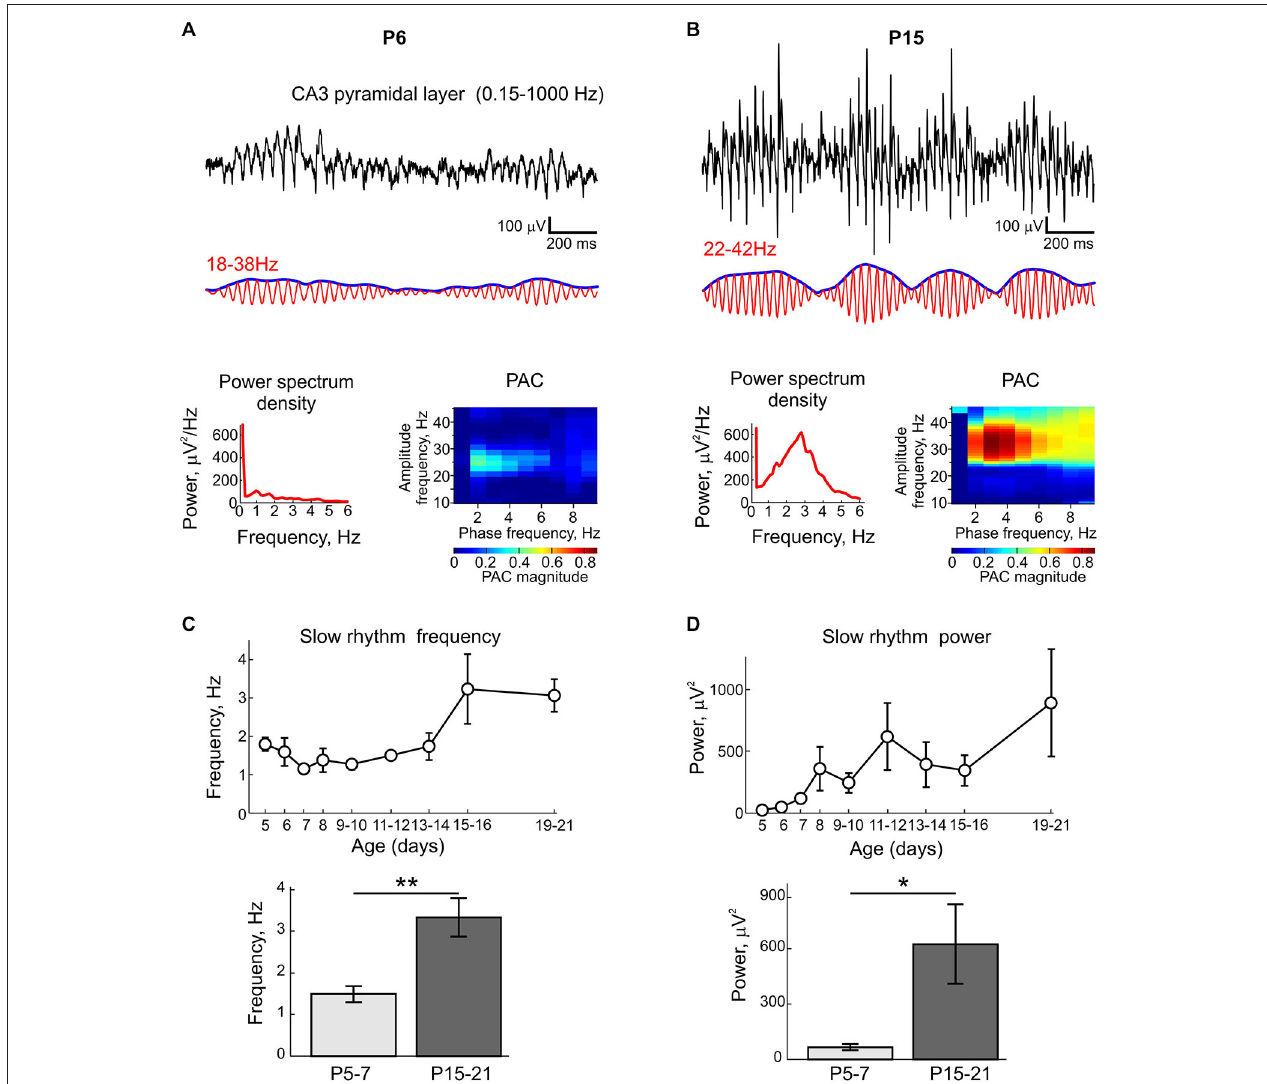
Below, corresponding power spectral densities and phase-amplitude coupling (PAC) color histograms. (C,D) Postnatal changes in slow rhythms frequency (C) and power (D) . Below, group data for P5–7 and P15–21 respective values. Pooled data from n = 35